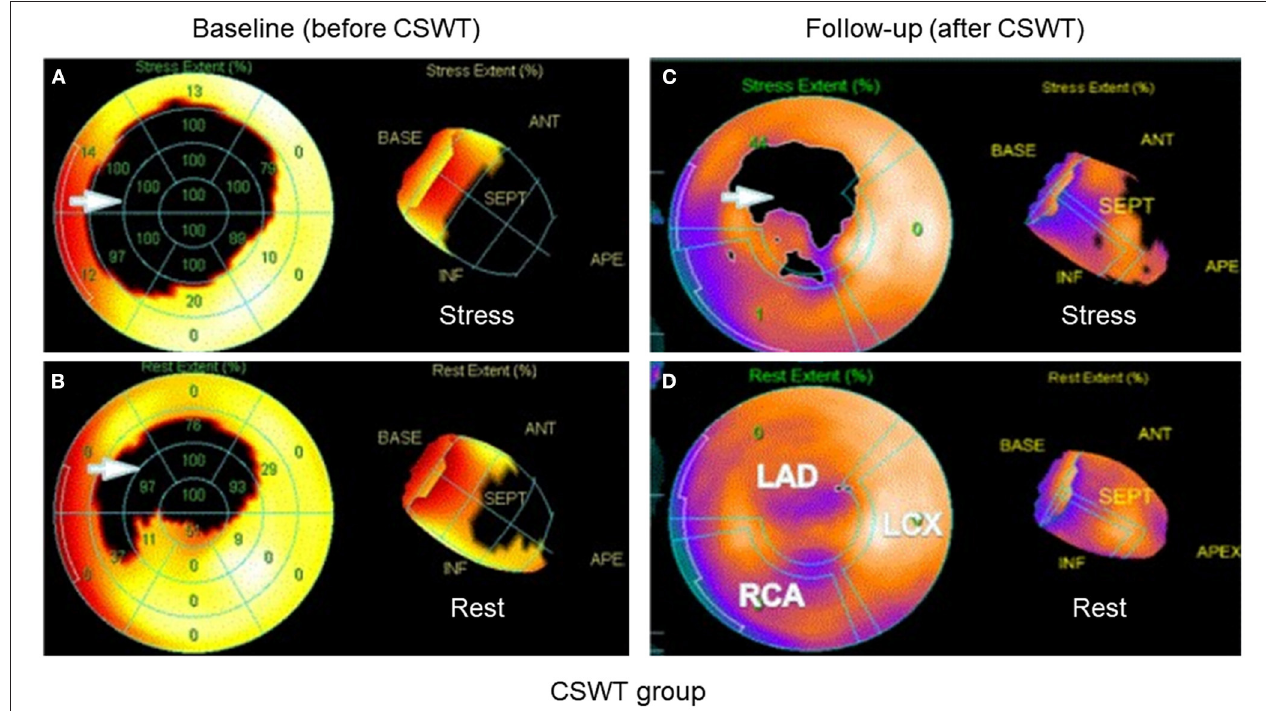
FIGURE 2 | D-SPECT of a patient. After CSWT, the ischemic myocardium at rest and stress procedure was significantly reduced at 6 months after treatment as compared to that before CSWT. (A) Before treatment at stress procedure. (B) Before treatment at rest procedure. (C) After treatment at stress procedure. (D) After treatment at rest procedure. Arrow: ischemic area. CSWT, cardiac shock wave therapy; D-SPECT, dynamic single photon emission computed tomography; LAD, left anterior descending artery; LCX, left circumflex coronary artery; RCA, right coronary artery.